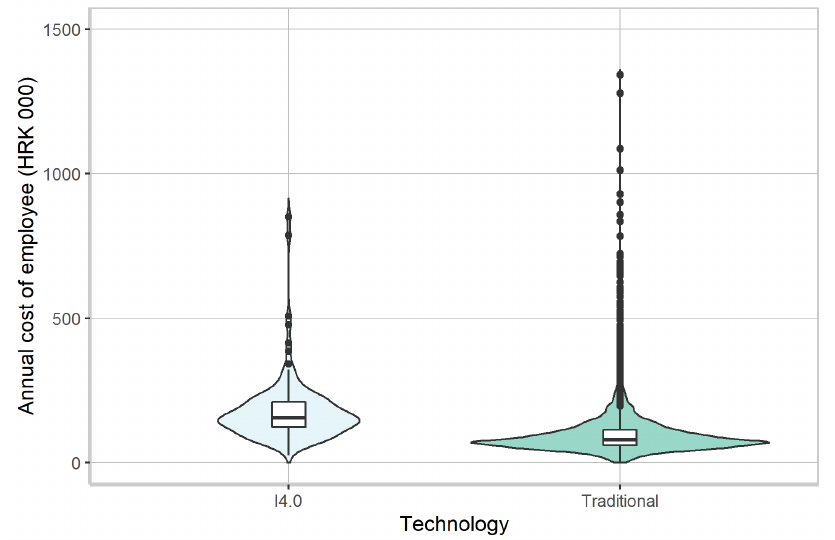
Figure 9. Distribution of the marginal rate of technical substitution (MRTS).